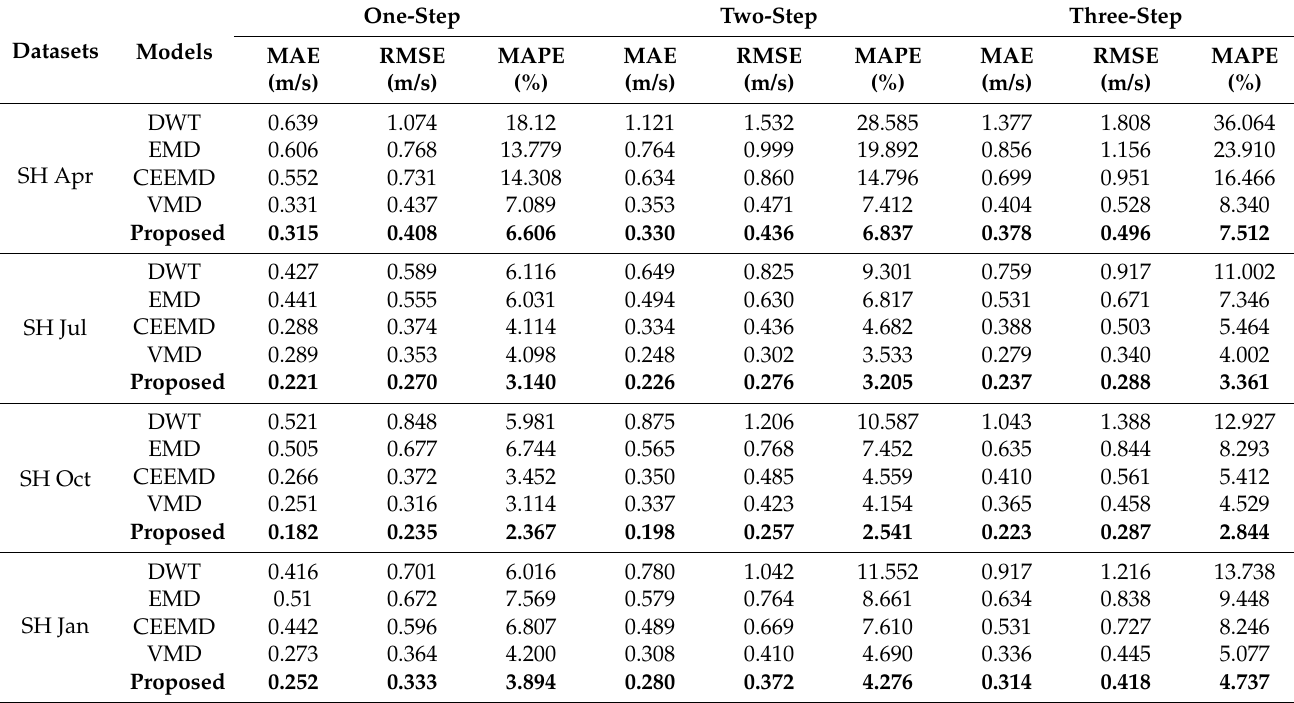
Table 4. Comparison of forecasting performances of the combined model and other models using different data preprocess- ing methods. DWT: discrete wavelet transform; EMD: empirical mode decomposition; CEEMD: complementary ensemble empirical mode decomposition; VMD: variational mode